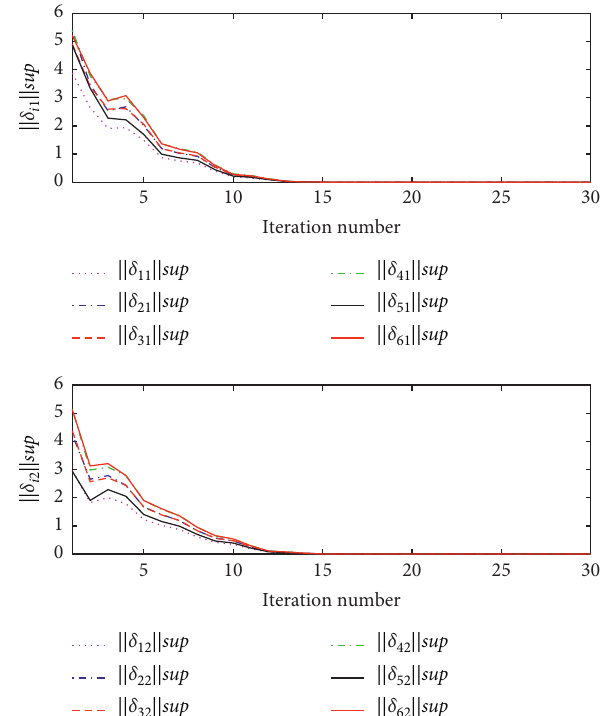
Figure 6: Formation errors of six followers for Case